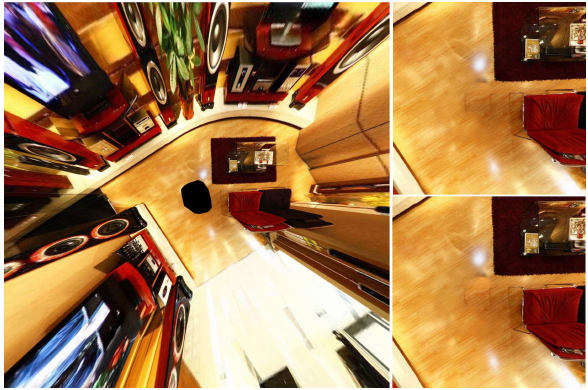
Figure 12. Comparative results of performing image blending without luminance compensation in the top-right corner and com- bining two methods in the bottom-right